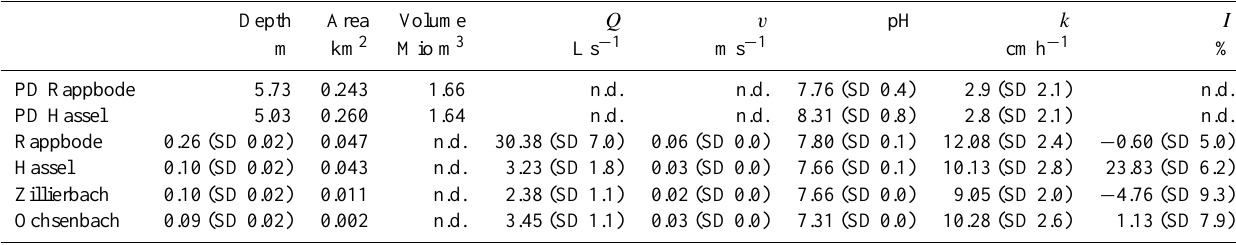
Table 1. Characterisation of the streams and reservoirs under investigation. ∗